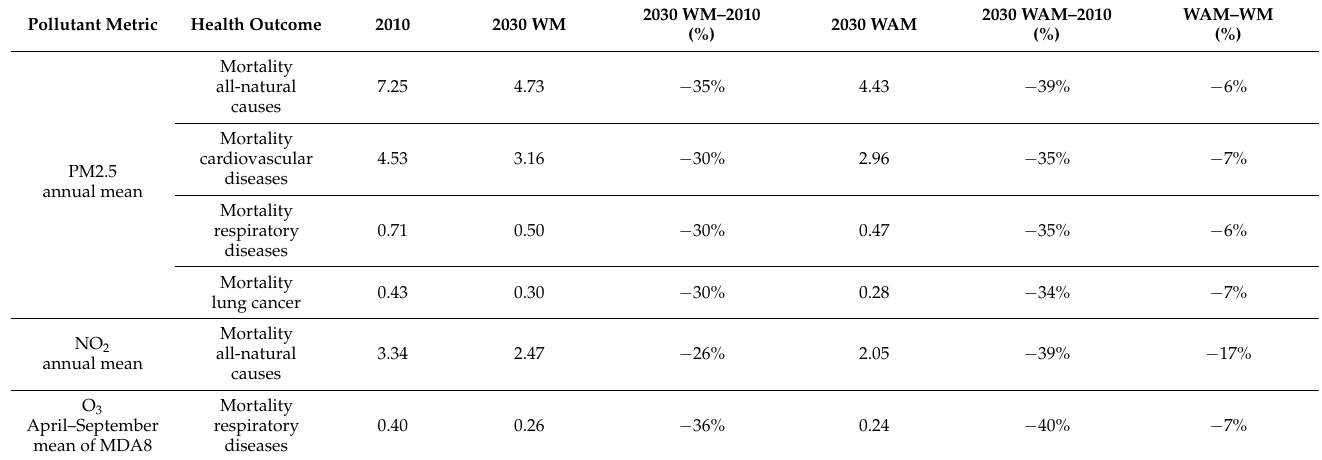
Table 10. National-level mortality rate over 10,000 inhabitants; national average (both sex); and variations between 2010, 2030 WM and 2030